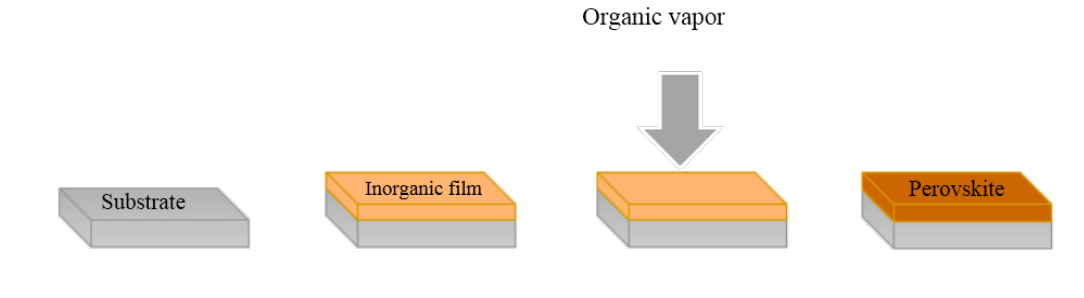
Figure 4: The vapor assisted solution process (VASP)